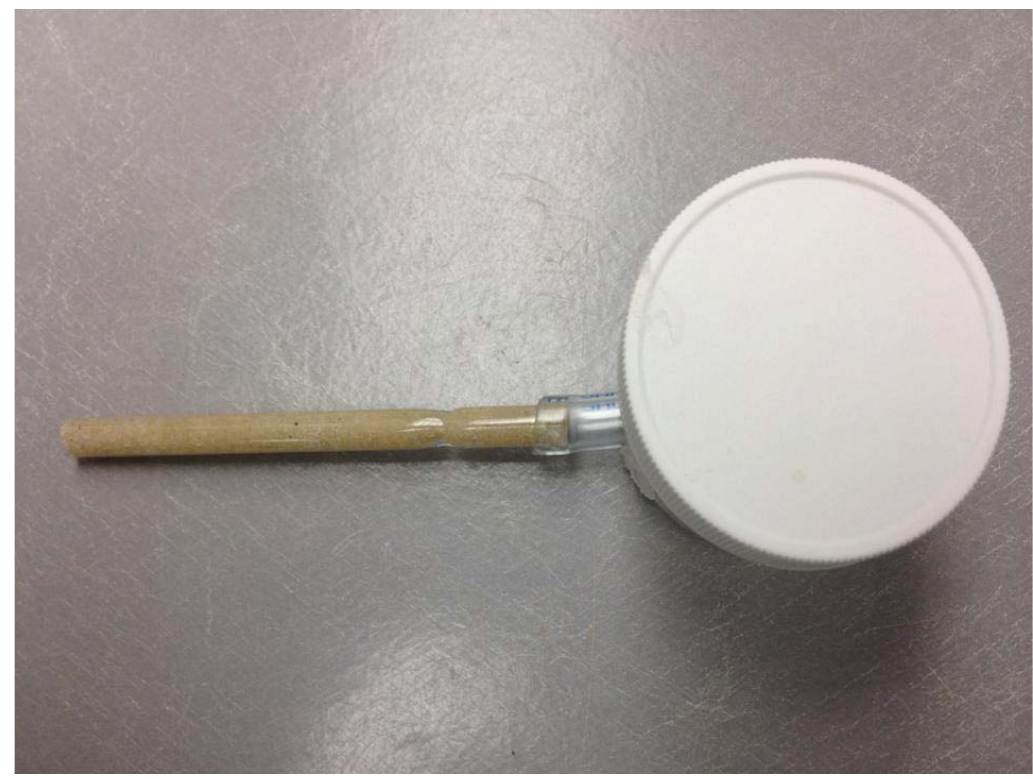
Figure 1. The testing apparatus for tunneling